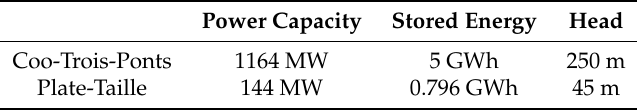
Table 1. Existing pumped hydro storage plants in